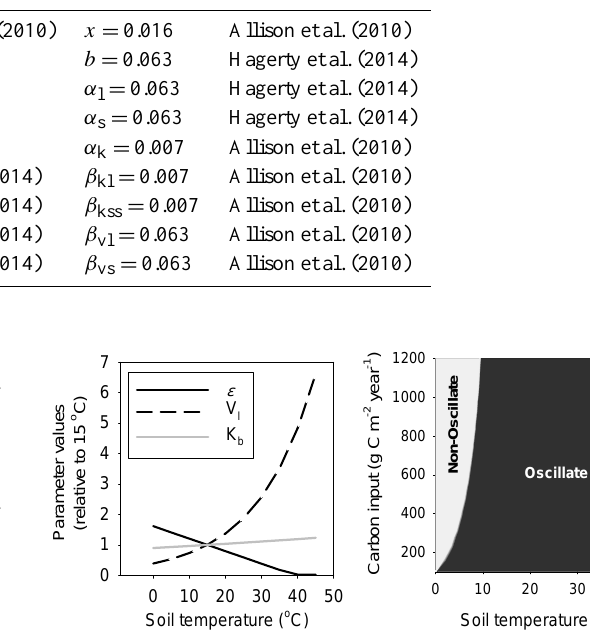
Figure 1. Variation in microbial growth efficiency ( ε ), V l , and K b with soil temperature (left panel) or the region in which model A has oscillatory or non-oscillatory response to a small perturbation (right panel) at different carbon input and soil